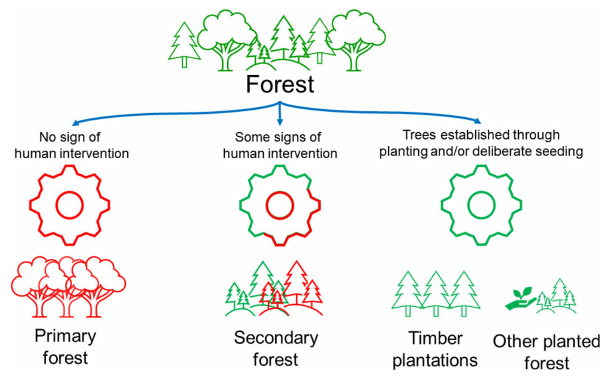
Figure 7. The forest classification in MAgPIE, built on FAO (2015) definitions and